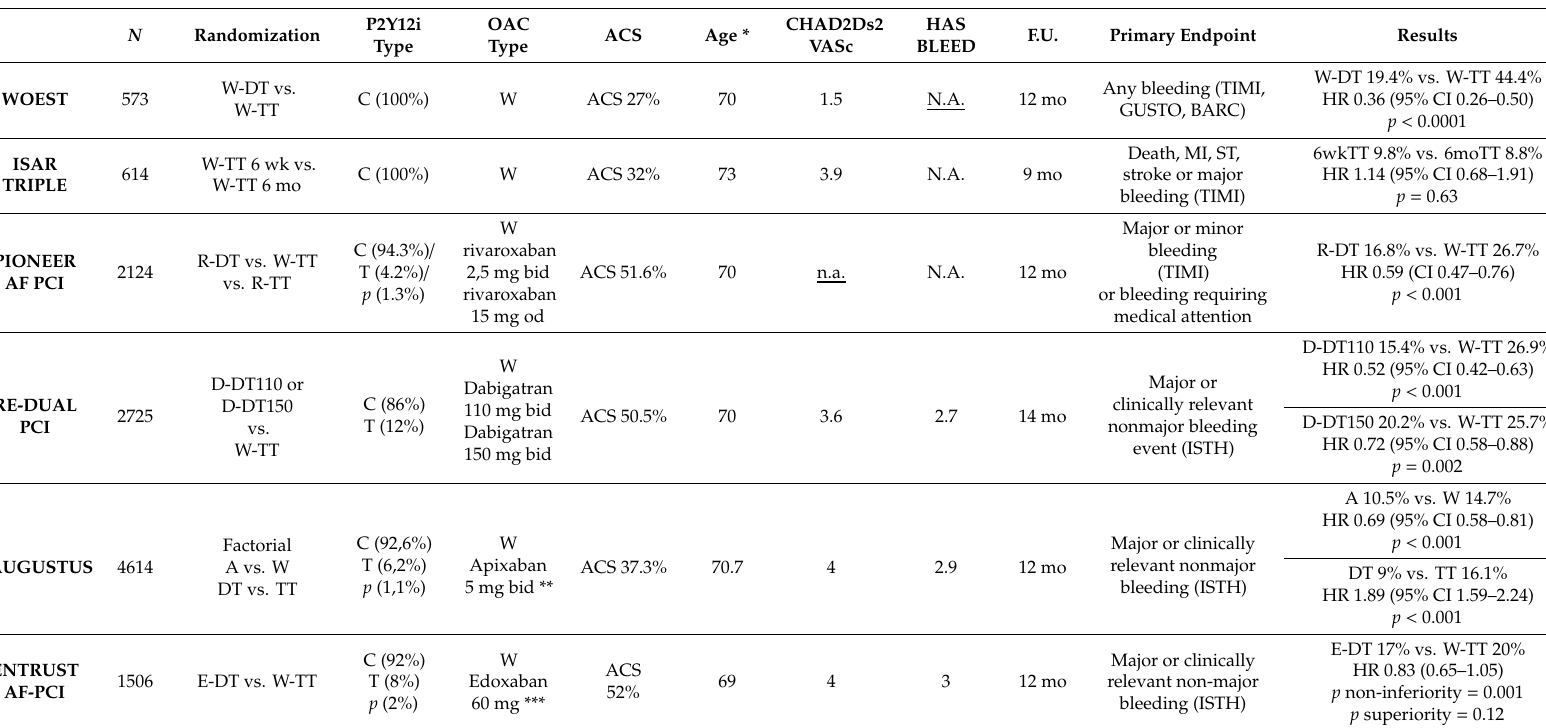
Table 3. Randomized controlled trials evaluating antithrombotic therapy type and duration in patients with non-valvular atrial fibrillation undergoing percutaneous coronary